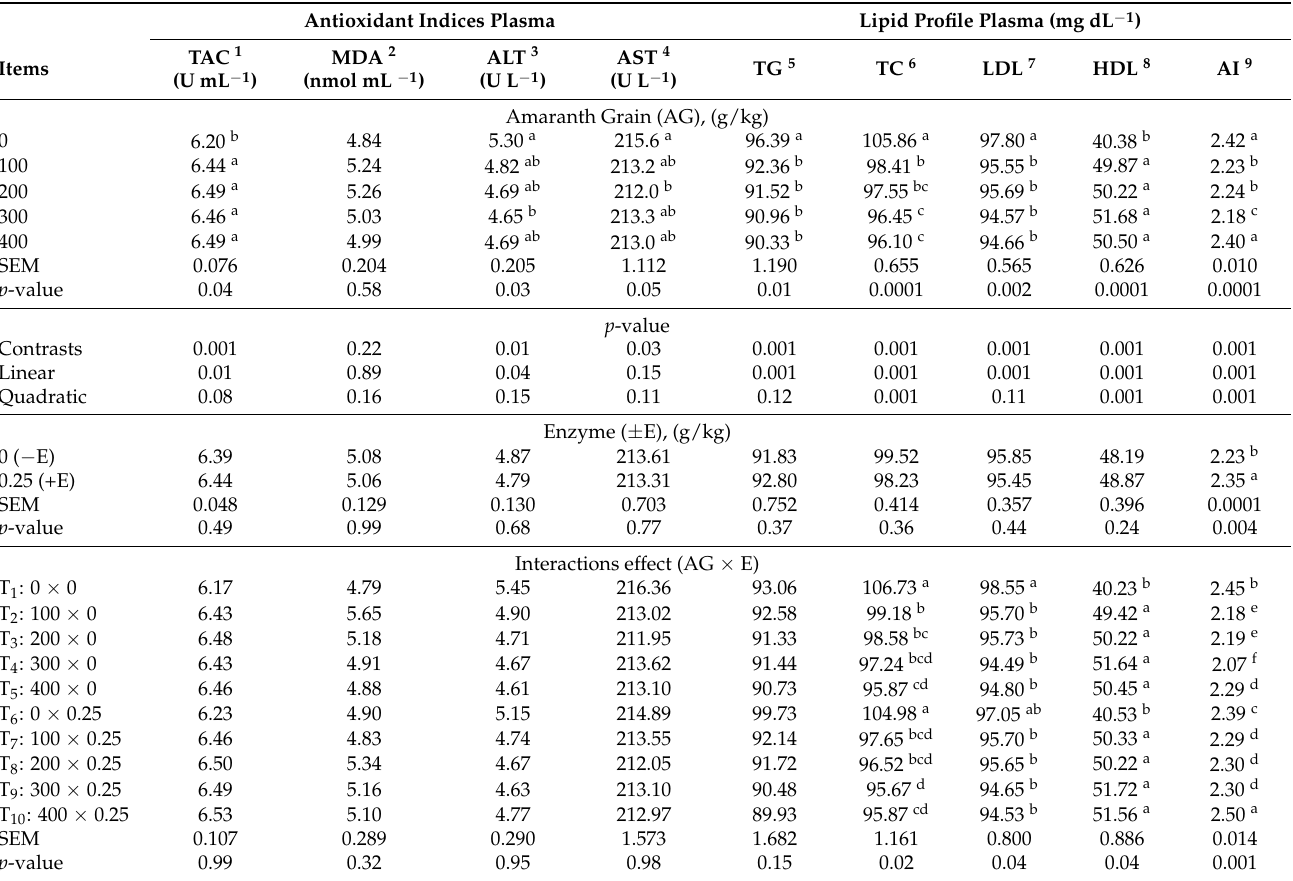
Table 5. Main effect of amaranth feeding, enzyme addition and interaction between amaranth feeding and enzyme addition on serum biochemical parameters of laying